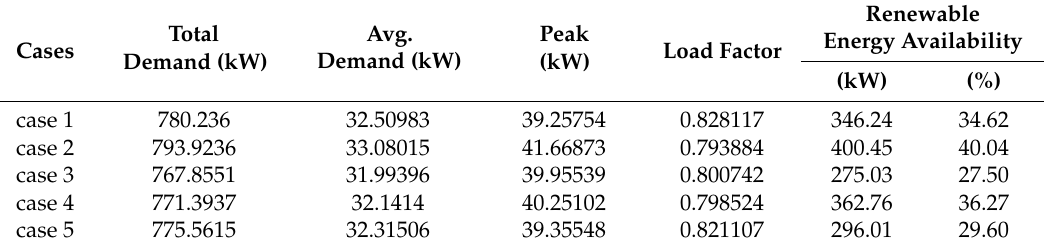
Figure 13. Load curves obtained for cases 1–5 with DSM.